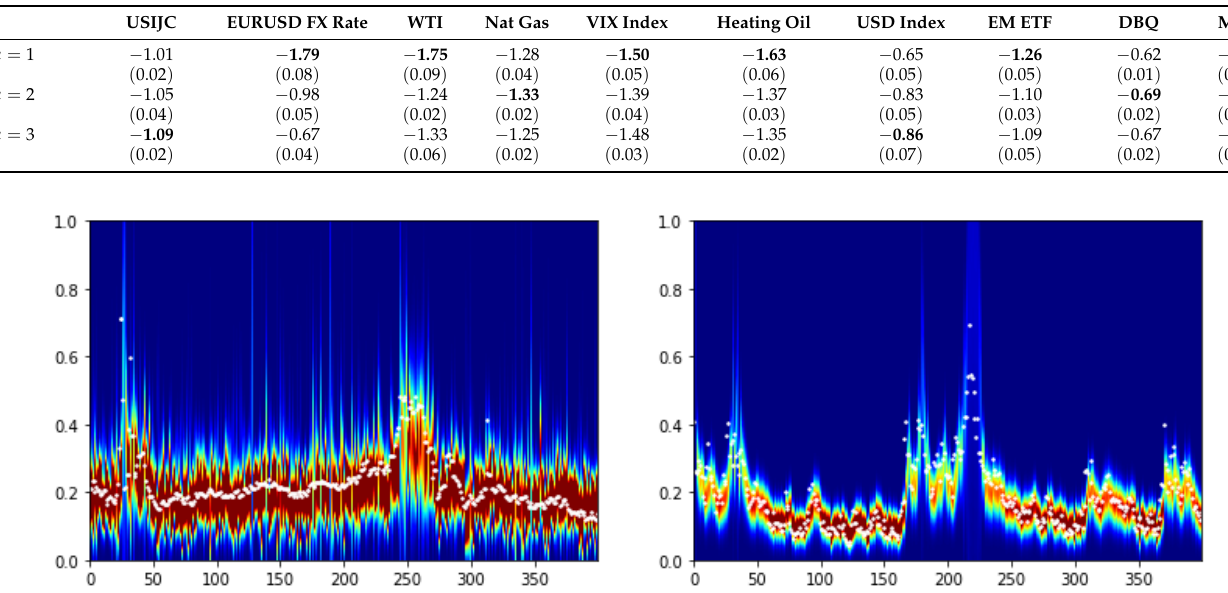
Figure 5. Estimated distributions for ( left ) Nat Gas with m = 2 and ( right ) VIX index with m = 1 over out-of-sample test datasets. True samples are shown as white dots. Red indicates high data likelihood, and blue data low likelihood, under the MD-CGAN